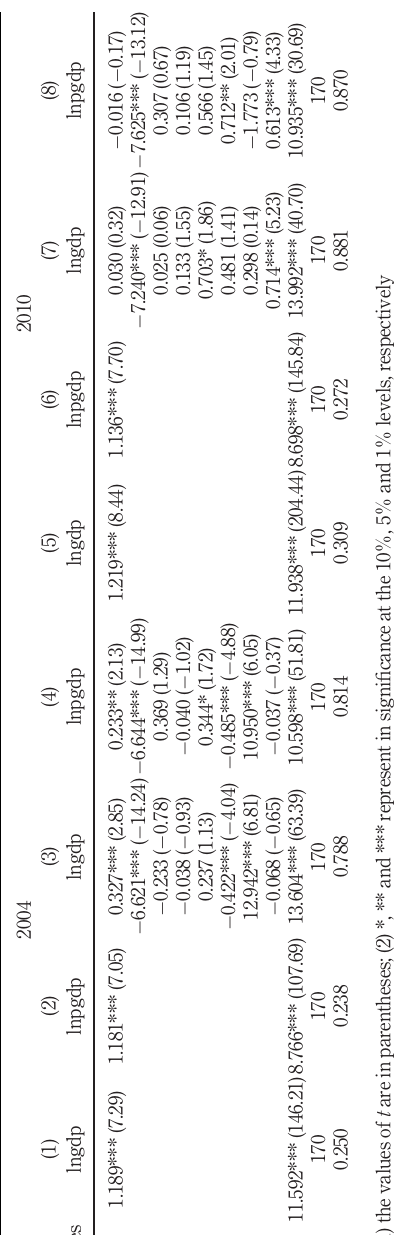
Table 4. The average